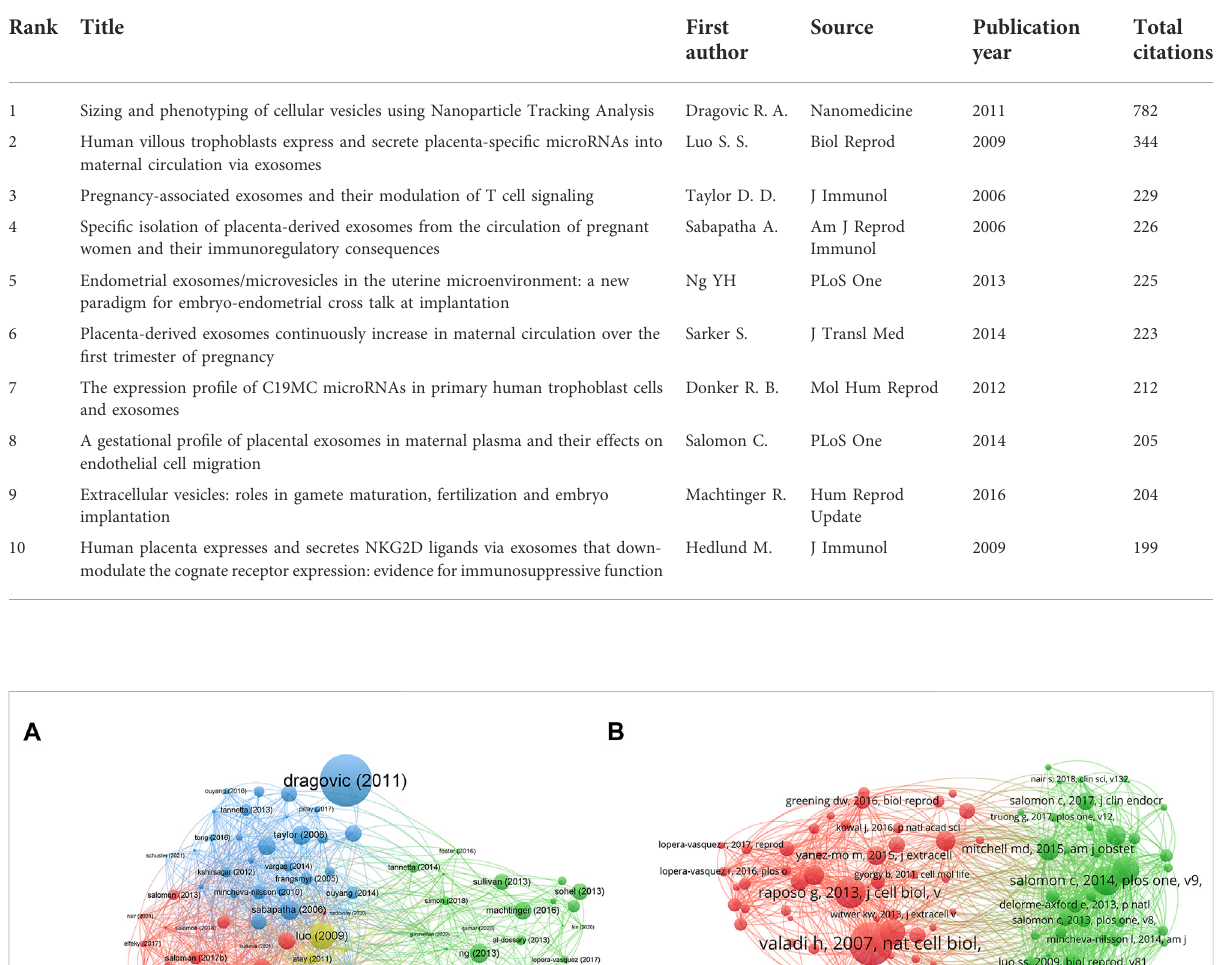
TABLE 4 Top 10 documents in citation analysis of publications on exosomes in reproduction.